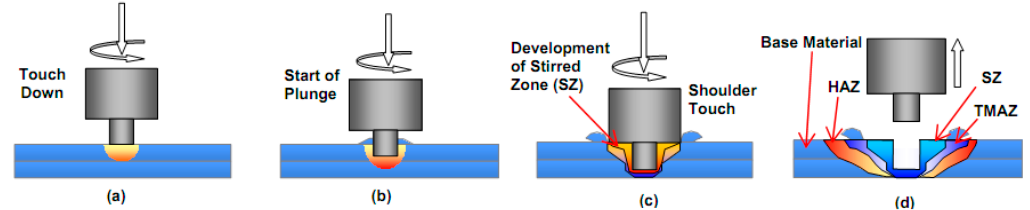
Figure 1. Schematic illustration of the Friction stir spot welding (FSSW) process. ( a ) touch down of rotating tool; ( b ) start of pin penetration to commence plunge; ( c ) plunge ends by shoulder touch and development of weld zones; ( d ) retraction of the tool with weld zones formed.